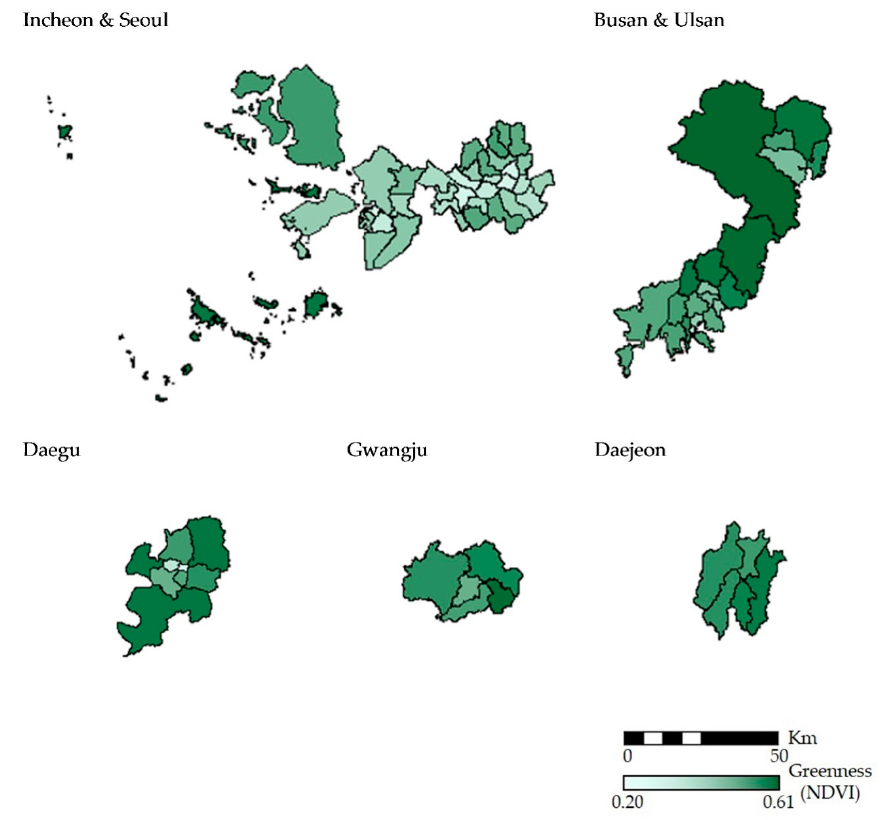
Figure 1. The spatial distribution of greenness level (annual average NDVI) of the study area.